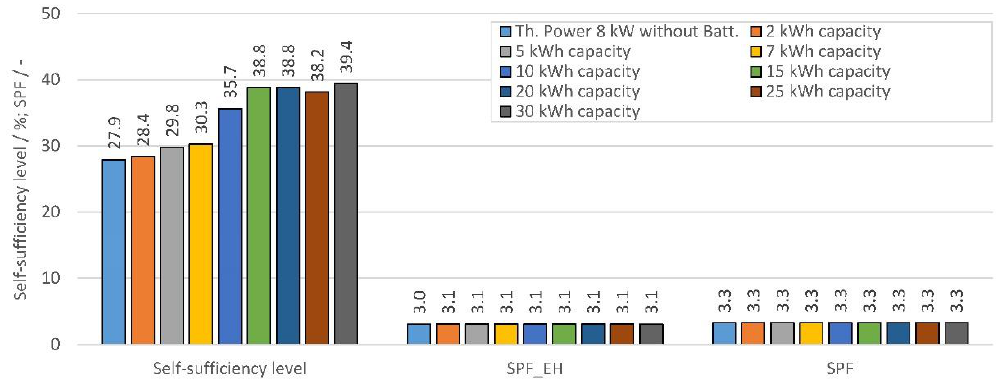
Figure 8. Self-sufficiency level (SSL) and seasonal performance factors of SFH category 3 reference buildings equipped with a BWHP for year 2020 with variation of battery size